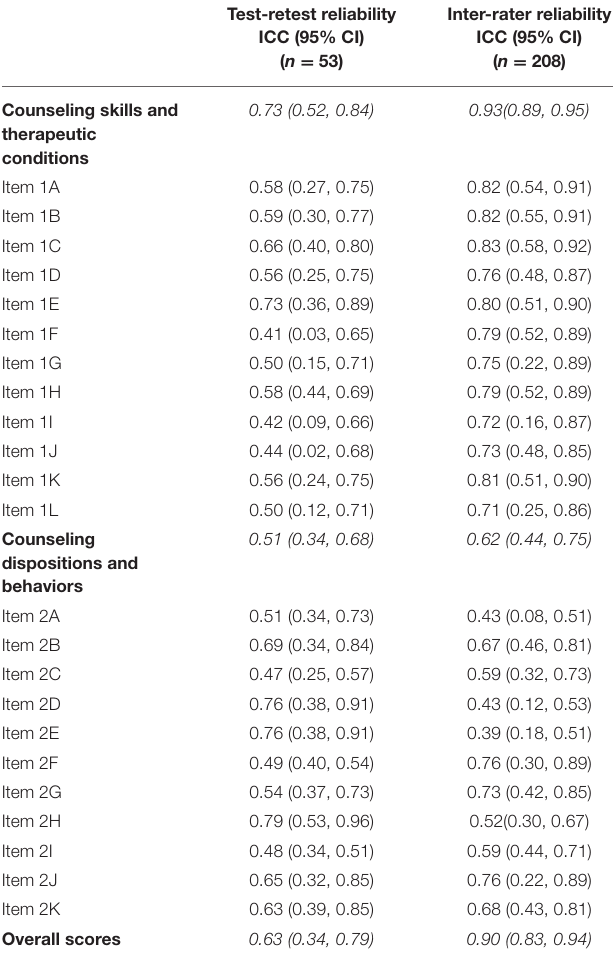
TABLE 5 | Test-retest reliability and interater reliability of the counseling competencies